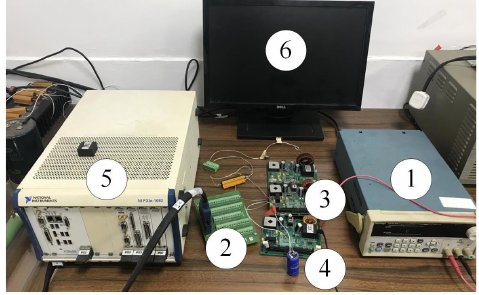
Figure 7. The hardware setup of the three-charger testbed: (1) power source; (2) measurement board; (3) three buck converters; (4) ultracapacitor; (5) PXI platform; (6)